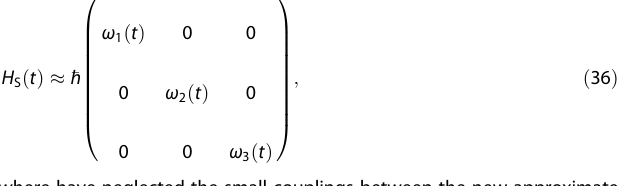
Fig. 7 Energy levels in the Jacobian diagonalization scheme for the four lowest eigenstates. We show the Jaynes – Cummings diagonalization for the states | 0, 1, g 〉 and | 0, 0, e 〉 , and the successive fi rst diagonalizing transformation for the states | 1, 0, g 〉 and | + 〉 }, which is relevant for the case λ L+ ≥ λ L − (see text). The resulting approximative eigenfrequencies are ω 1 = ω − , ω 2 = ω ↓ , and ω 3 = ω ↑ . The angular frequencies ω ± , ω " = # , ω av and Ω ij are de fi ned in the are the states corresponding to the approximative eigenvalues (cid:2) h ω " = # ð t Þ . Thus in Eq. (34), the Hamiltonian ^ H S ð t Þ is represented in the basis (cid:2)j i ; # ð t Þj i ; " ð t Þj if g . For all values of the control parameter ω L ( t ) of our protocol, the perturbation parameter λ "(cid:2) ð t Þ (cid:4) 1 and, thus, further